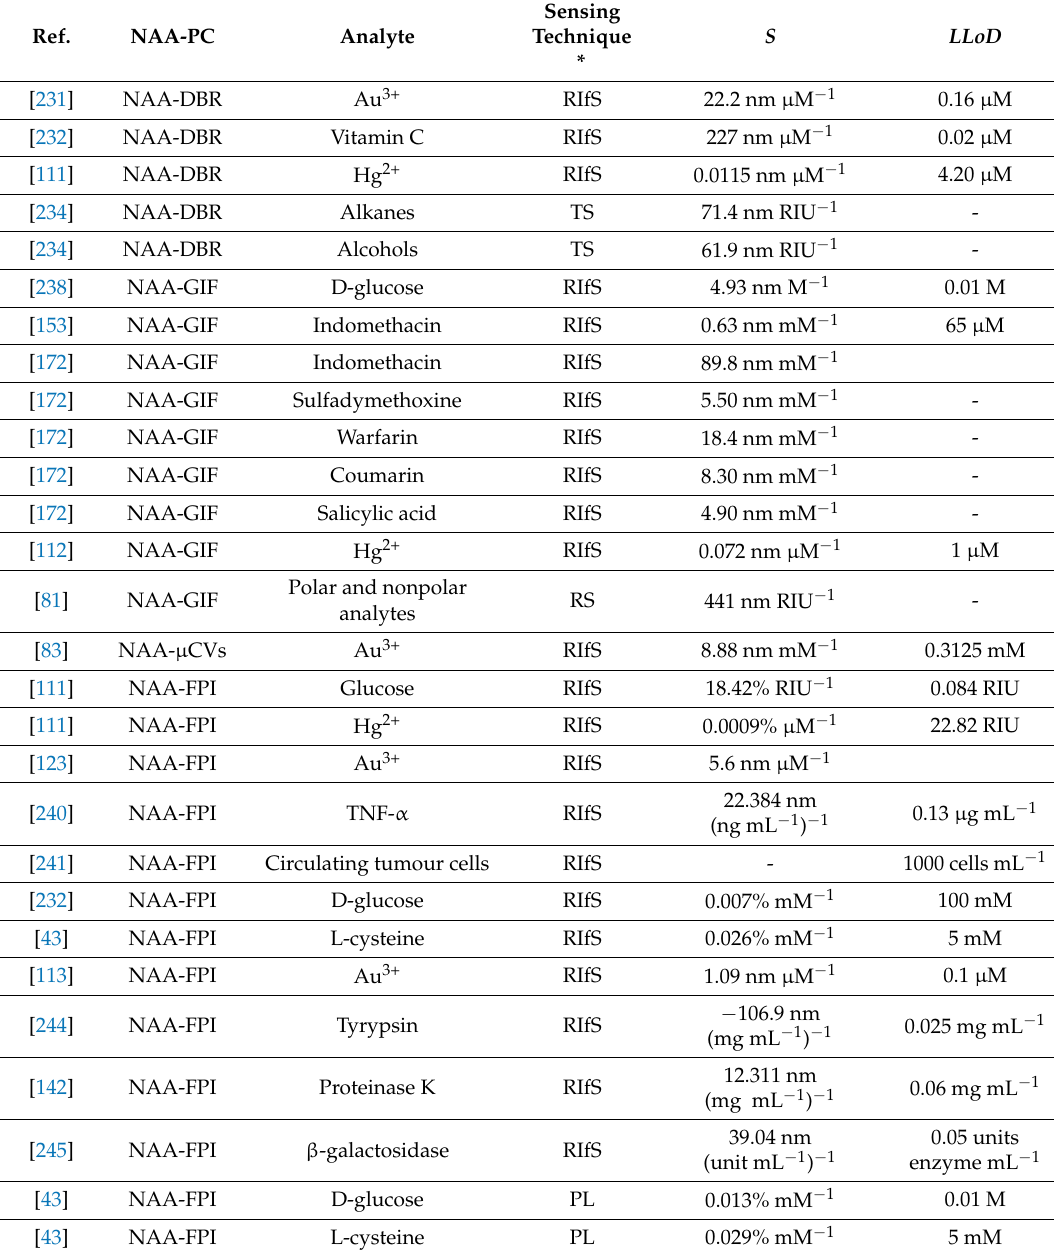
* RIfS = reflectometric interference spectroscopy, TS = transmission spectroscopy, RS = reflection spectroscopy, and PL = photoluminescence